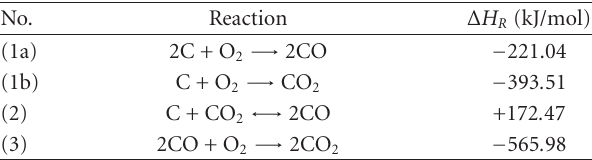
Table 1: Chemical reactions relevant in graphite